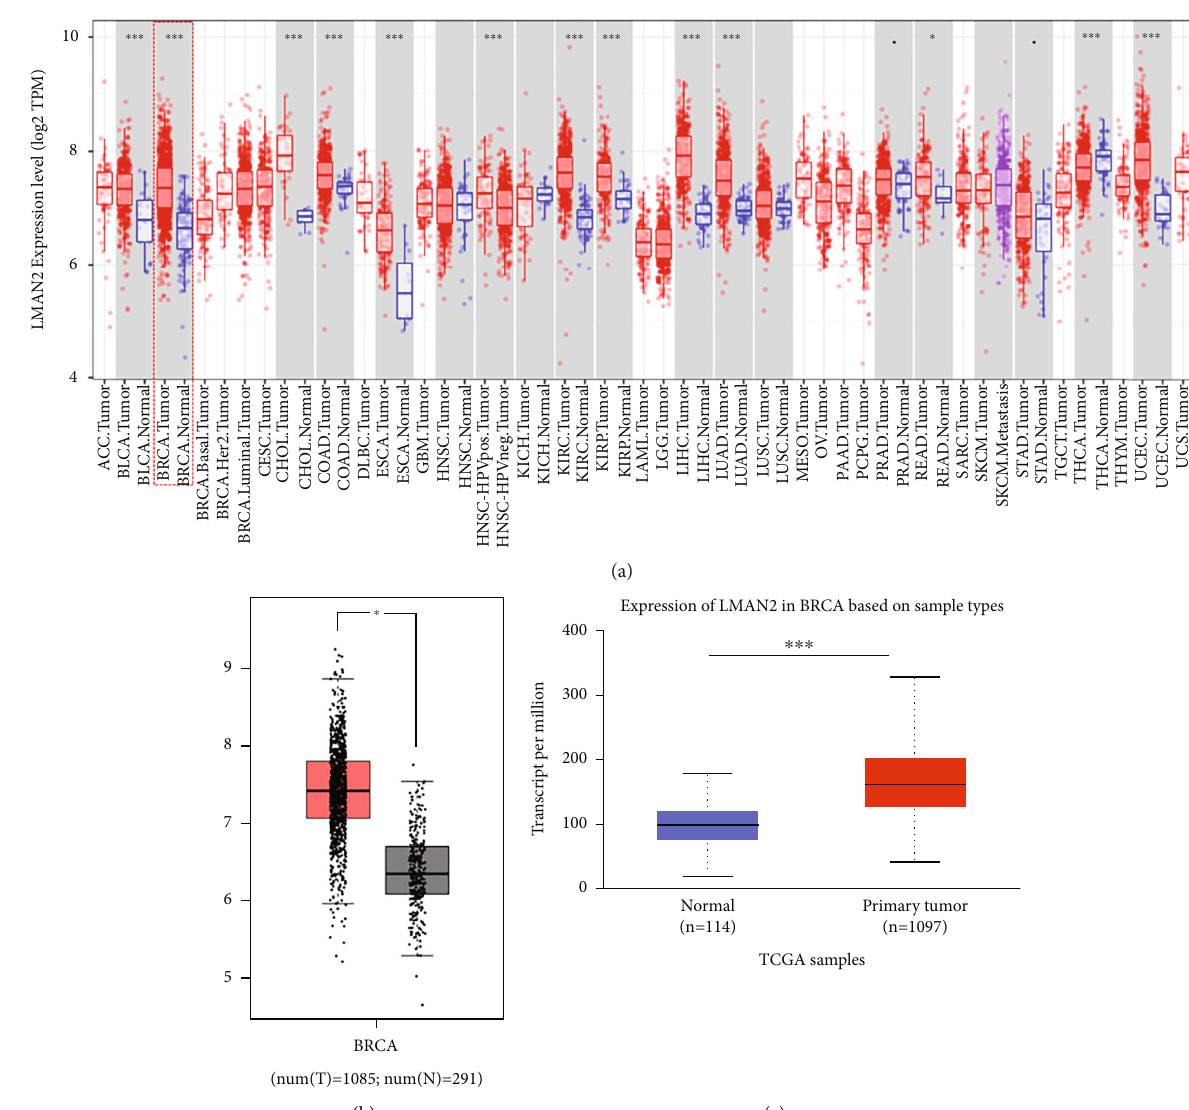
Figure 1: High expression level of LMAN in breast cancer cells. (a) The TIMER database was utilized to evaluate the LMAN2 expression in various malignancies. (b) The LMAN2 expression in normal and primary breast cancer tissues premised on the GEPIA database. (c) The expression of LMAN2 in normal and primary breast cancer tissues based on the UALCAN database ( ∗∗∗ p ≤ 0 : 001 ; ∗∗ p ≤ 0 : 01 ; ∗ p ≤ 0 : 05 Breast Cancer Gene-Expression Miner v4.7 (bc-GenExMi- ner v4.7), UALCAN, The Human Protein Atlas (HPA),